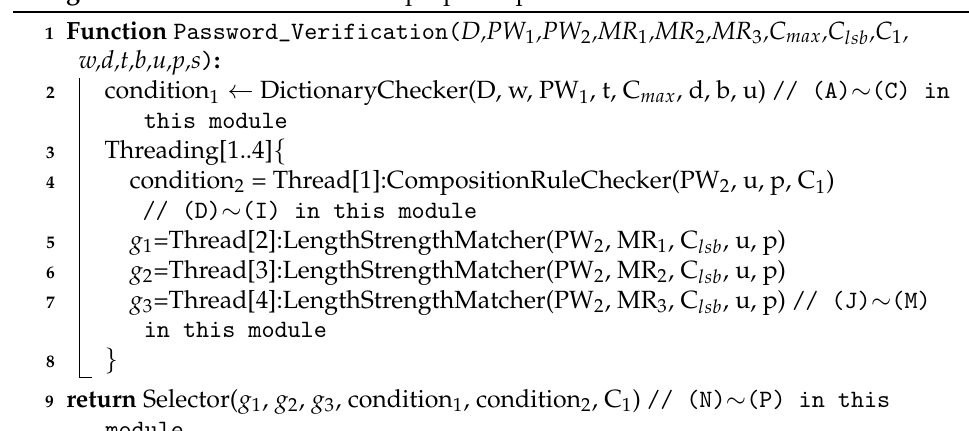
Algorithm 1: Pseudo-code of the proposed protocol